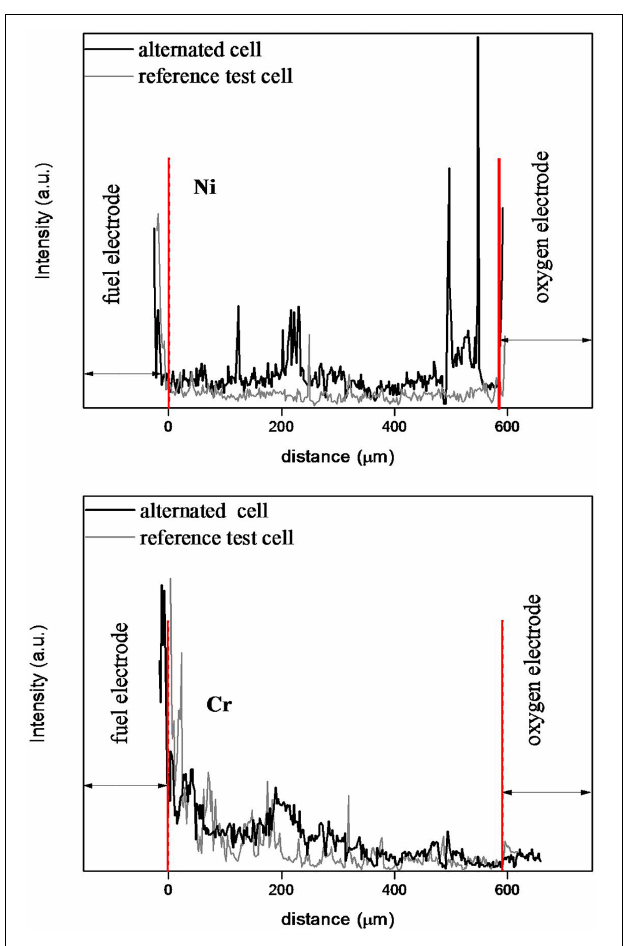
FIGURE 8 | EDX elemental analysis distribution of Cr and Ni across the matrix cross-section of reverse and reference test cells.